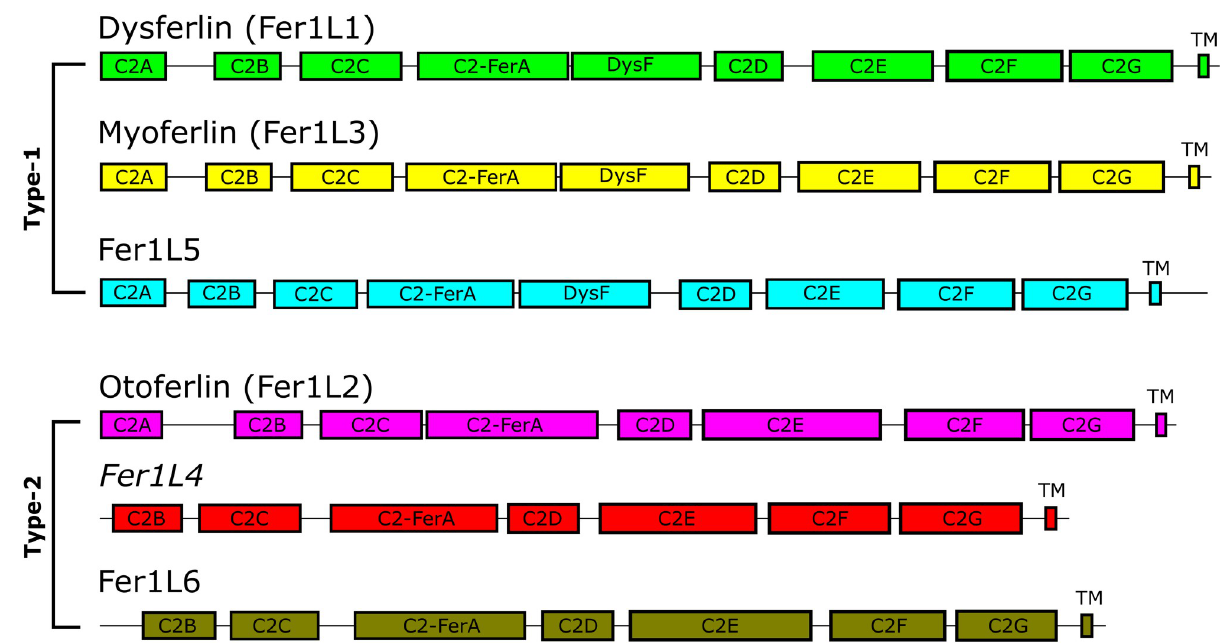
Fig 1. Scaled schematic diagram of the human ferlin family members. The length of the total protein is in proportion to the length of each domain. The six ferlin proteins are segregated by type. Type-1 ferlins possess a DysF domain; Type-2 ferlins lack a DysF domain [37]. ‘TM’ indicates the transmembrane span. � Fer1L4 in humans is currently characterized as a pseudogene.